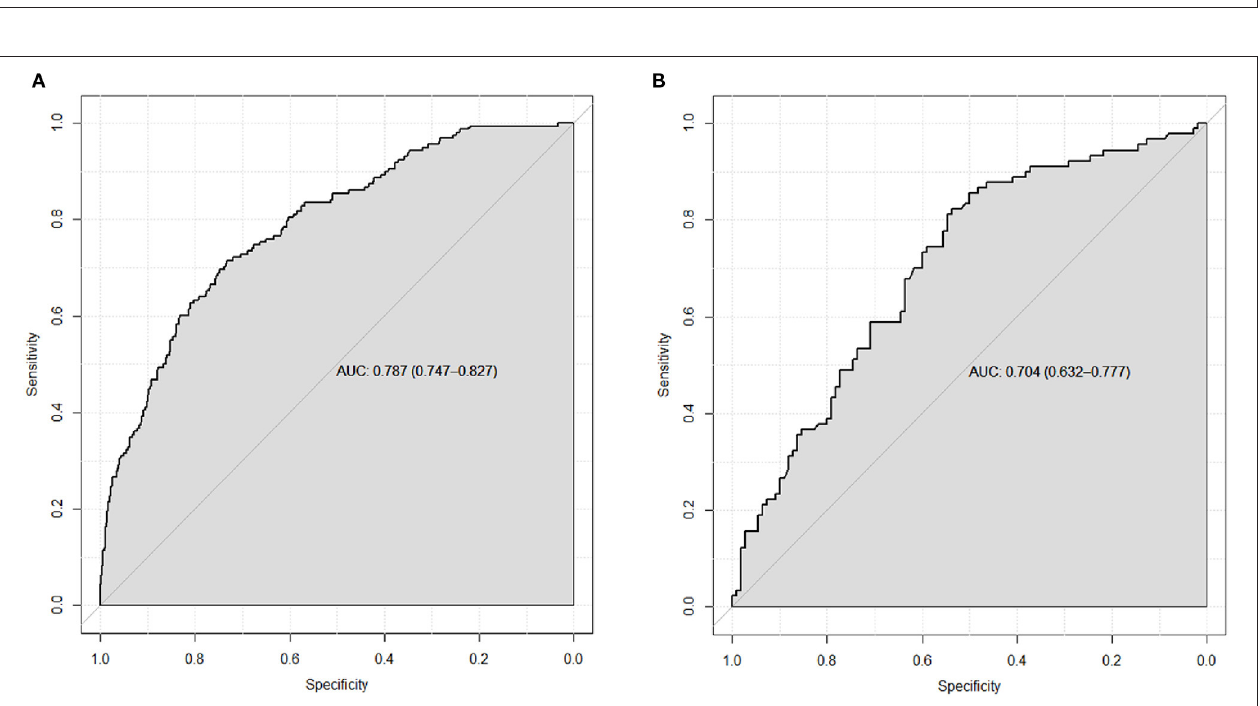
FIGURE 2 | (A) ROC curve for the nomogram based on the full Zhongnan Hospital dataset. The bias-corrected AUC is 0.772 based on internal validation using bootstrap resampling (1,000 patients) (B) ROC curve from an external, independent validation using the Jinyintan Hospital dataset. The estimate of AUC and its 95% confidence interval are shown in the plots. Key: ROC, receiver operating characteristic. AUC, area under the curve.